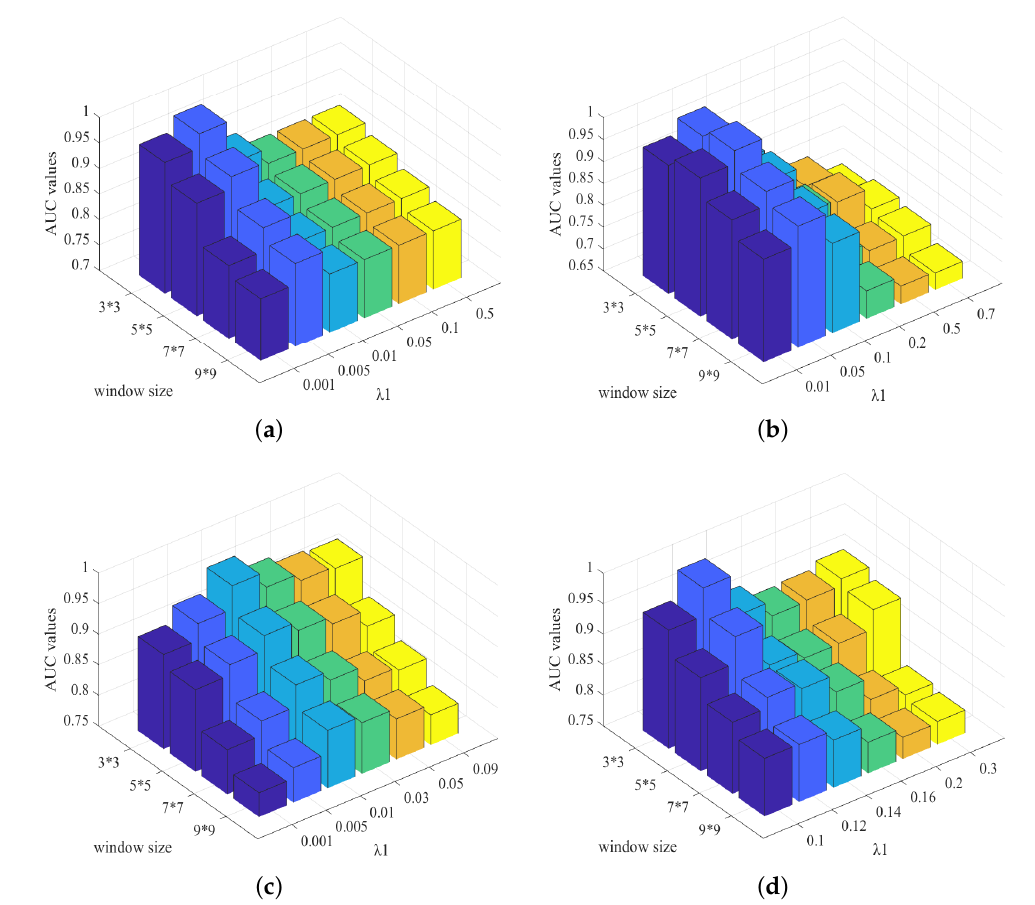
Figure 14. Analysis of the tradeoff parameter λ 1 and window size in gray level co-occurrence matrix (GLCM) on four different datasets. ( a ) Simulated dataset; ( b ) AVIRIS–I dataset; ( c ) AVIRIS–II dataset; ( d ) HYDICE dataset.